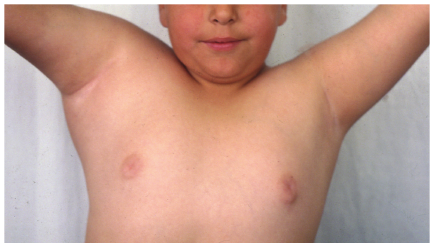
Figure 1: The scapula cyst raises in the axilla and limits abduction of the right shoulder.